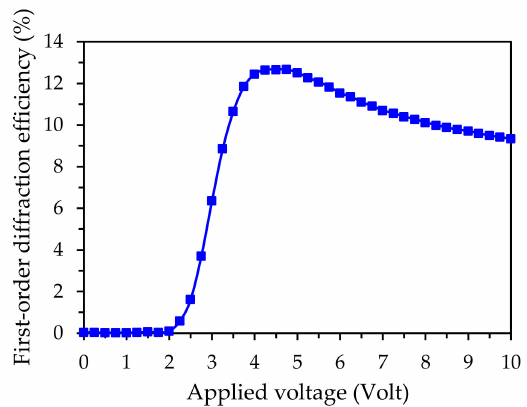
Figure 2. E ff ect of the applied voltage variation on the first-order di ff raction e ffi ciency of the electrically tunable